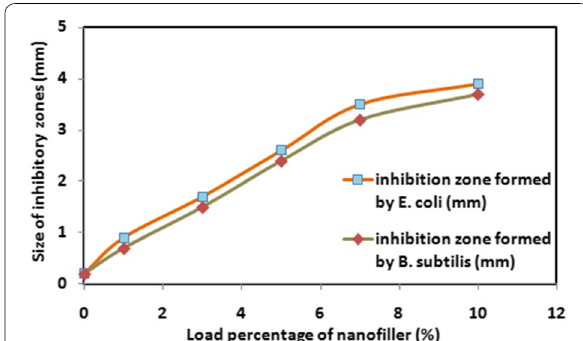
Fig. 4 Size of inhibitory zones versus load percentage of Cr in nano- composites Table 1 Size of inhibitory zones of antibacterial test of the POC/Cr nanocomposites Load percentage of nanofiller (%) Size of inhibitory zones